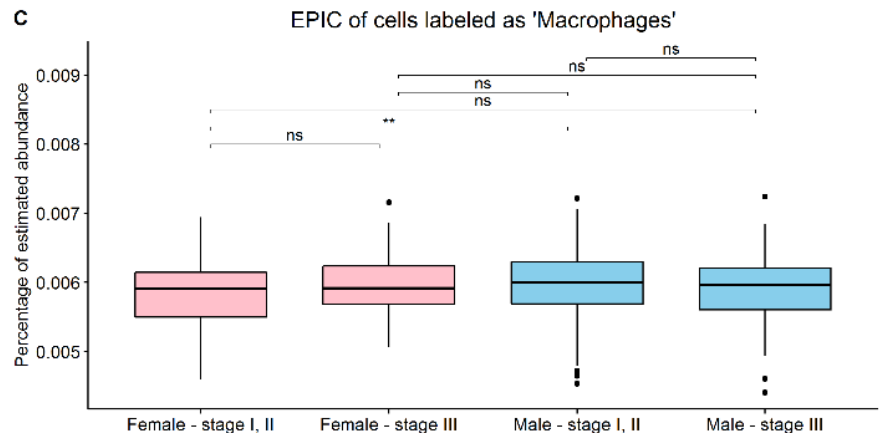
Figure 4. Estimate proportion of immune and cancer cells (EPIC) was performed on the sex/stage subgroups. The estimate was done on cells labeled as ( A ) “other cells”—representing for the most part cancer cells, ( B ) CD4 T cells, and ( C ) macrophages. ns = not significant, * p < 0.05, ** p < 0.01, *** p < 0.001, **** p < 0.0001